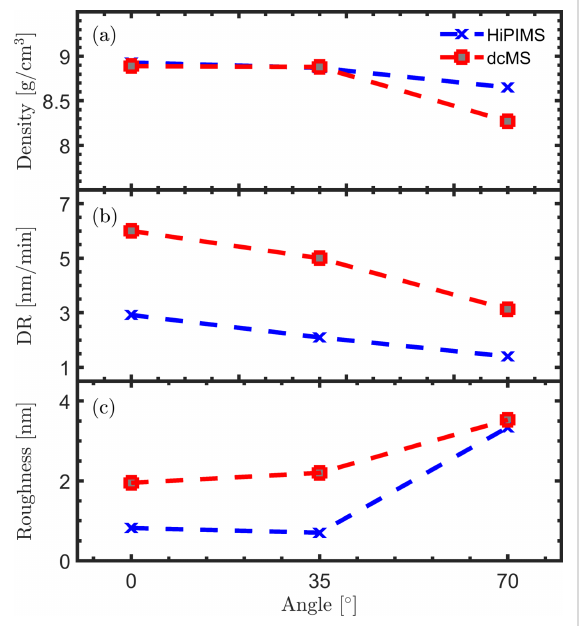
Figure 1: (a) Film density, (b) deposition rate, and (c) surface rough- ness of nickel films deposited by HiPIMS and dcMS. The data was extracted from XRR measurements. All films are deposited at 0.6 Pa working gas pressure, 150 W average power. In the HiPIMS case we used a pulse length of 200 μ s and a repetition frequency of 100 Hz.